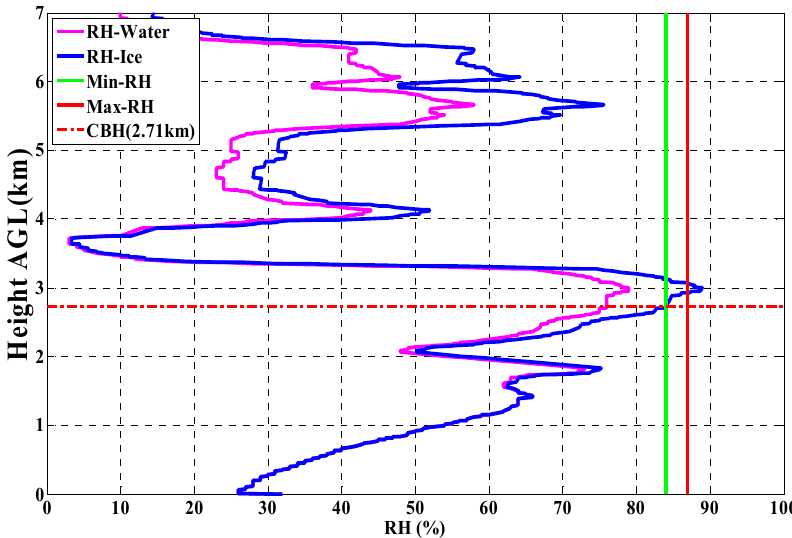
Figure 10. Radiosonde relative humidity (RH) profile and results of observed cloud structure.